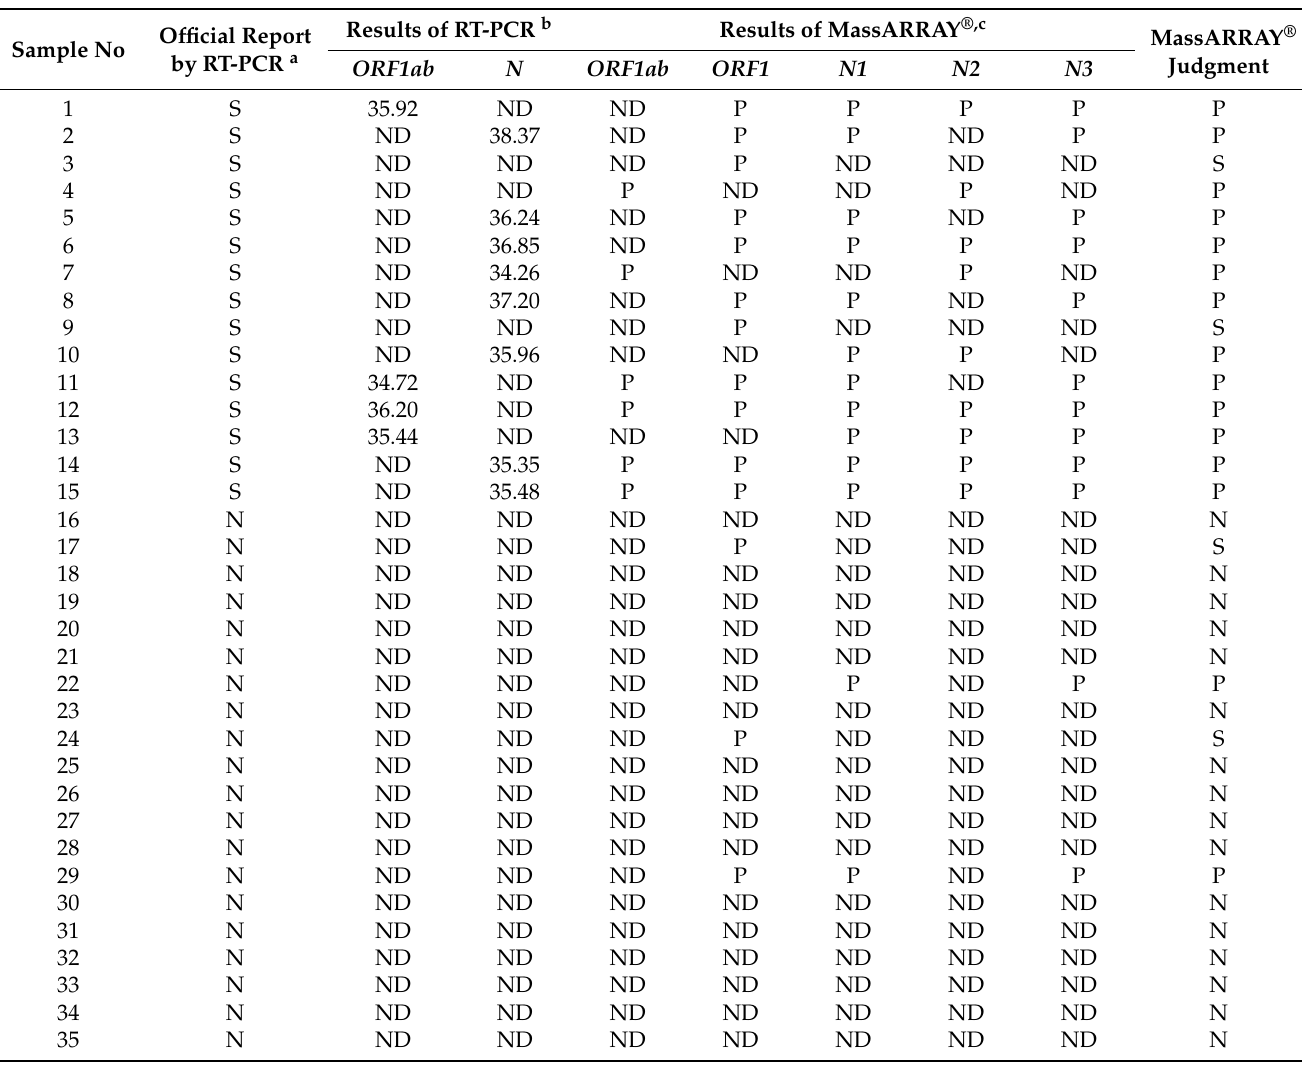
Table 3. RT-PCR and MassARRAY ® System results obtained for 35